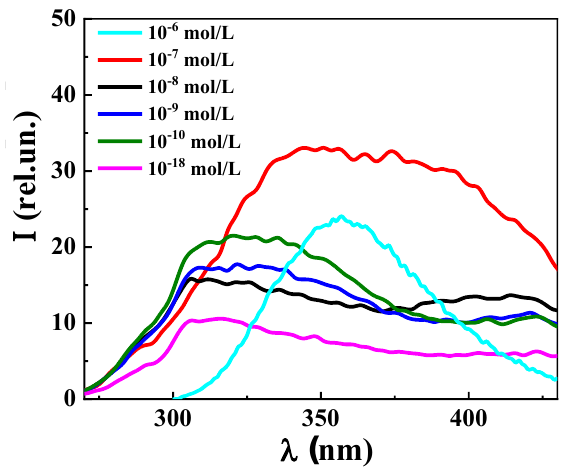
Figure 6. Fluorescence spectra ( λ ex 225 nm) of L -Trp systems, 25 ◦ C. At 1 × 10 − 6 mol/L, medium voltage was used; at 1 × 10 − 7 mol/L and below, high voltage.